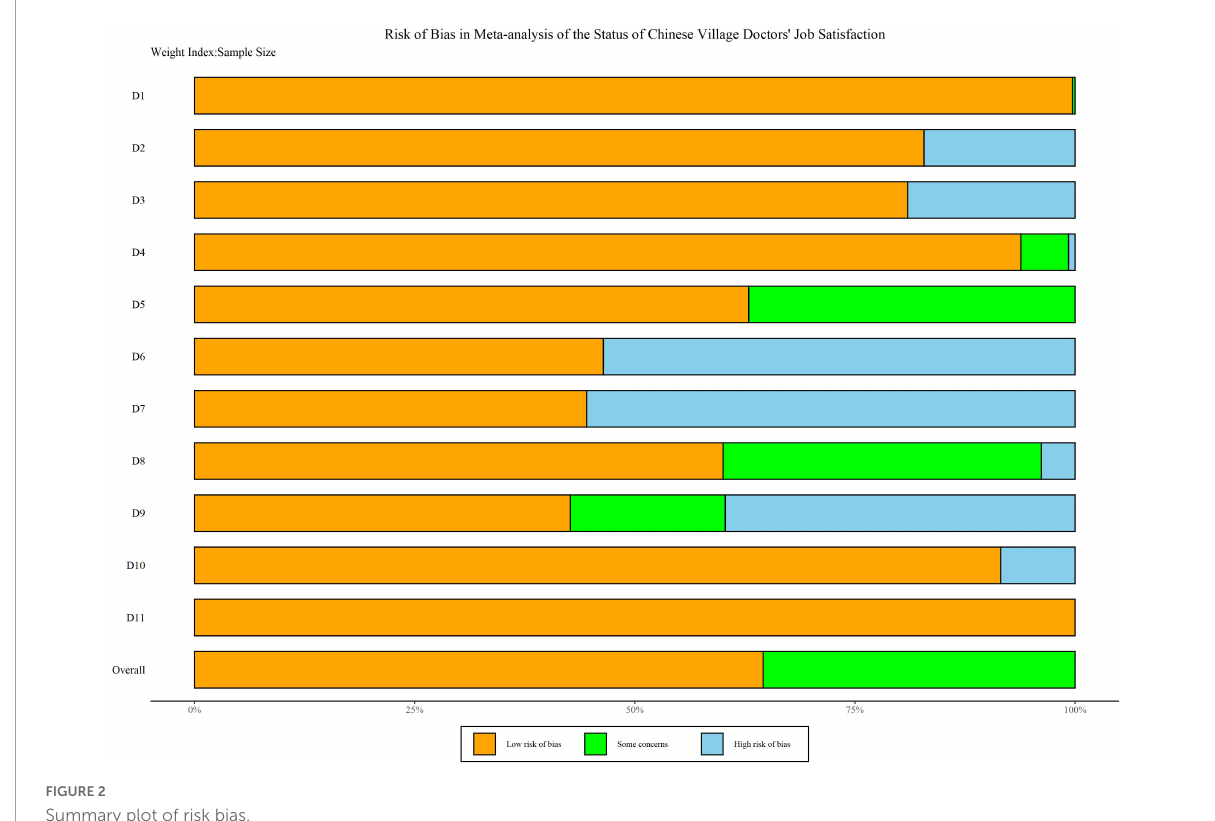
FIGURE2 Summary plot of risk